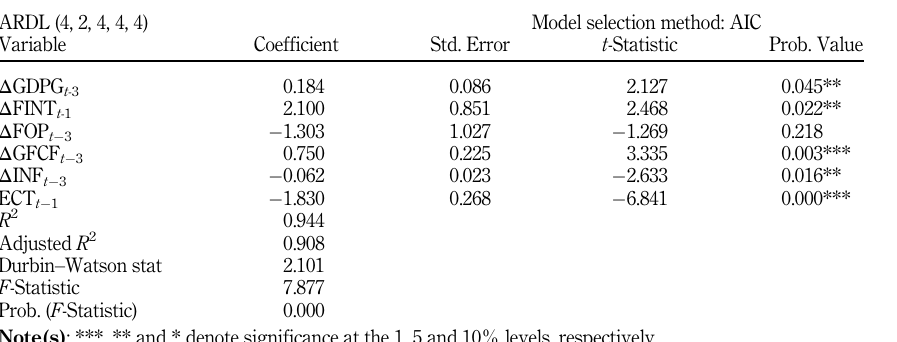
Table 5. Results of short-run